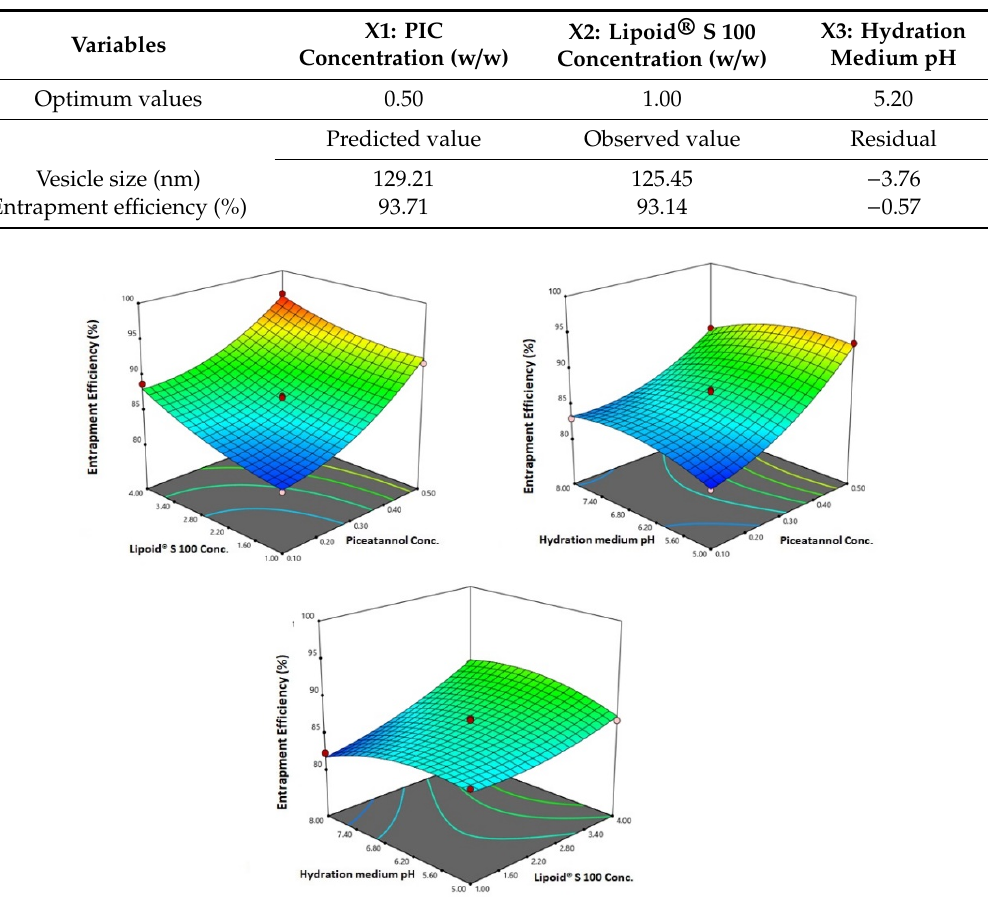
Figure 3. 3D response surface plots for the e ff ect of PIC concentration, Lipoid ® S 100 concentration, and pH of hydration medium on entrapment e ffi ciency % of PIC-E. Table 5. Optimized variables’ levels of optimized PIC-E and its predicted and observed responses.